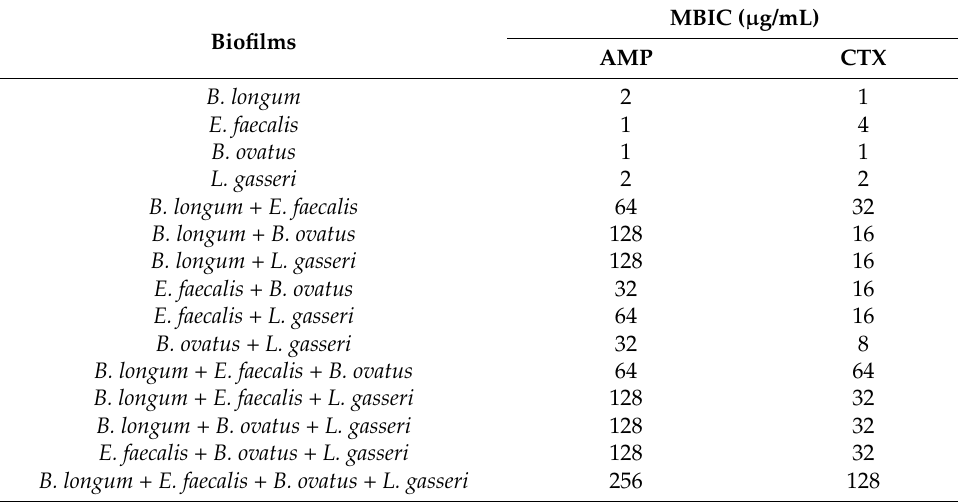
Table 1. Minimum biofilm inhibitory concentration (MBIC) of mono- and mixed-species biofilms. AMP: ampicillin; CTX: cefotaxime